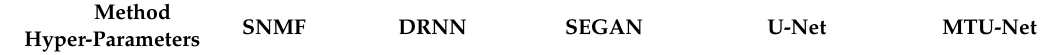
Table 1. Comparison of the model footprints of each speech enhancement method used in the